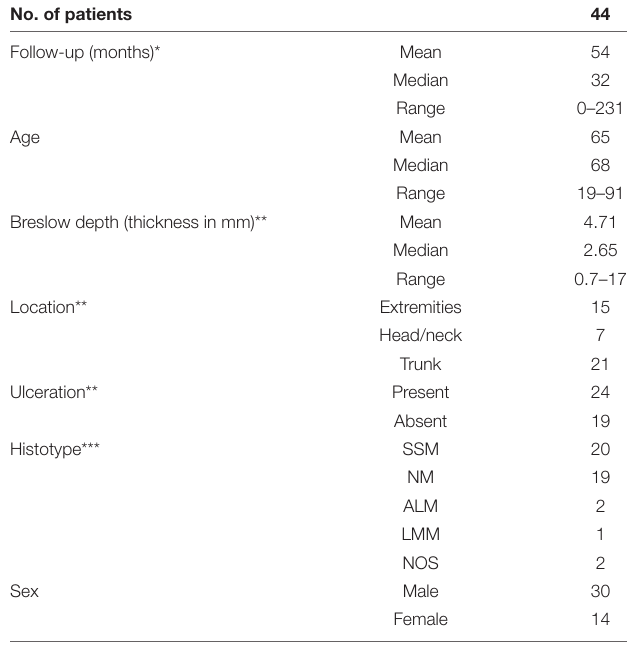
TABLE 2 | Clinical and histopathological summary of melanoma patients with primary tumors with subsequent